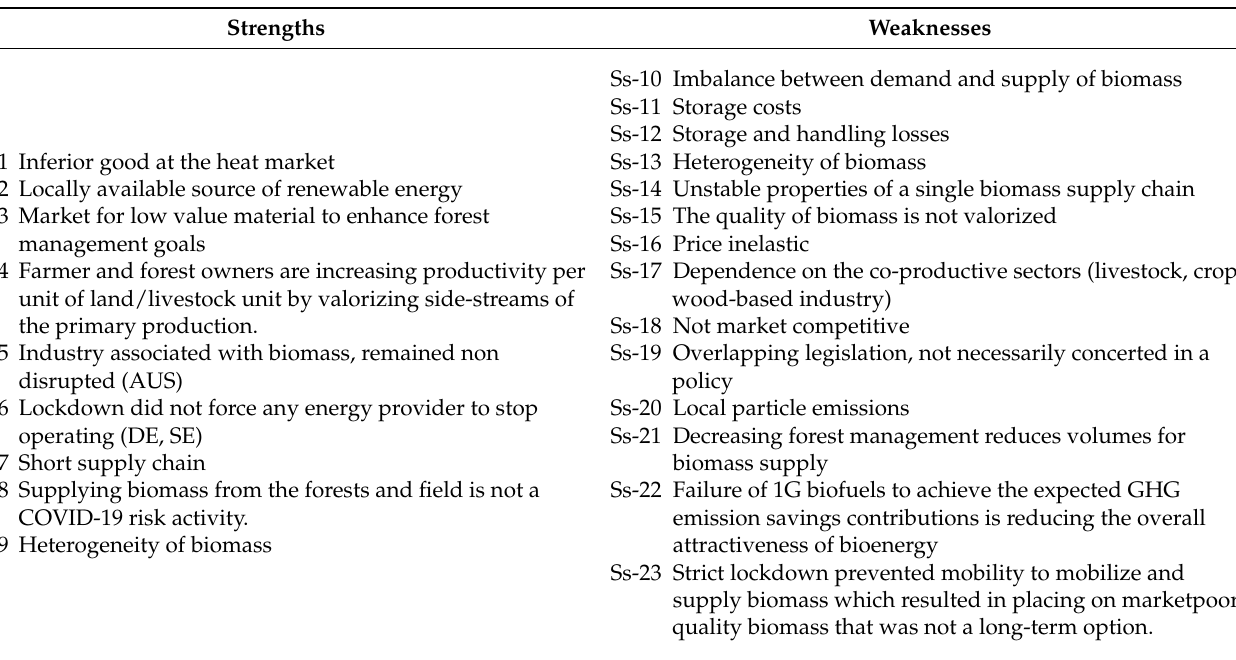
Table A1. Strengths and Weaknesses (SWOT) of biomass supply chains in respect to mobilizing and placing biomass to the market.